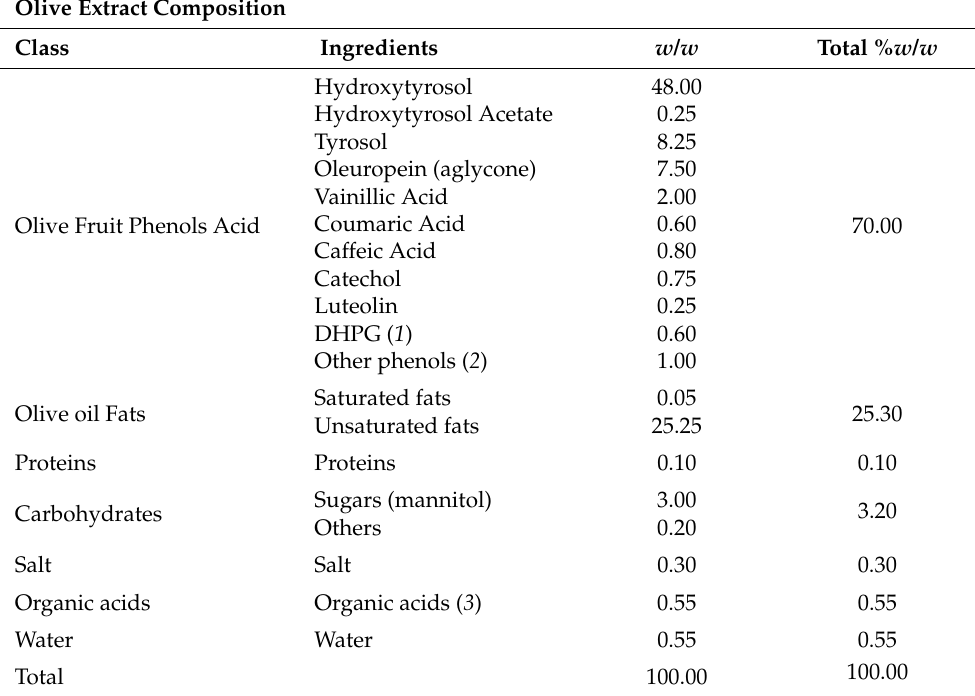
Table 1. Composition of the extract OLIVESAN ® 48% Syrup (olive extract rich in